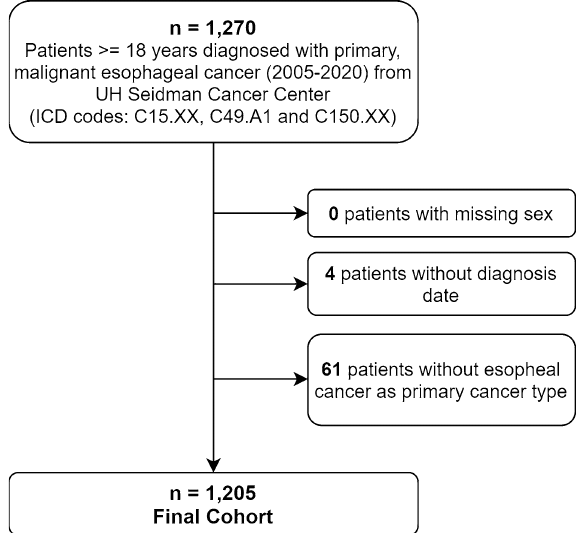
Figure 1. Cohort description with inclusion and exclusion criteria for UH institutional database. The final cohort included 1205 patients diagnosed with esophageal cancer from 2005 to 2020 with ≥ 18 years, excluding those without unknown diagnosis date, missing gender and without primary esophageal